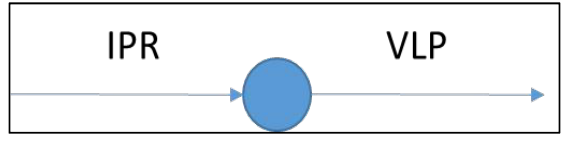
Figure 12—Nodal Analysis for Well Performance.